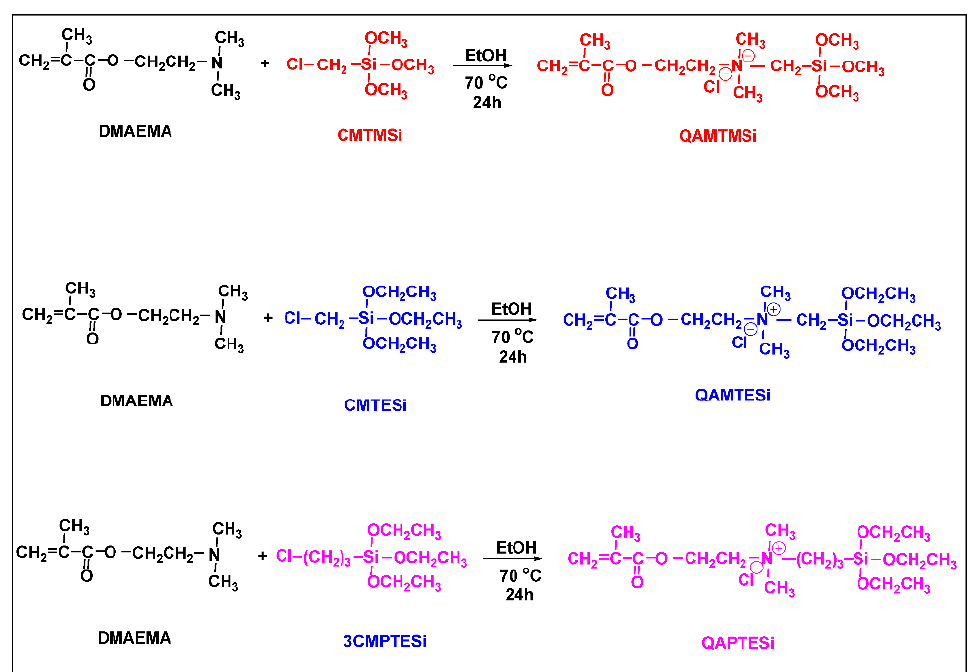
Scheme 1. Modified Menschutkin reactions applied for QASiC synthesis.